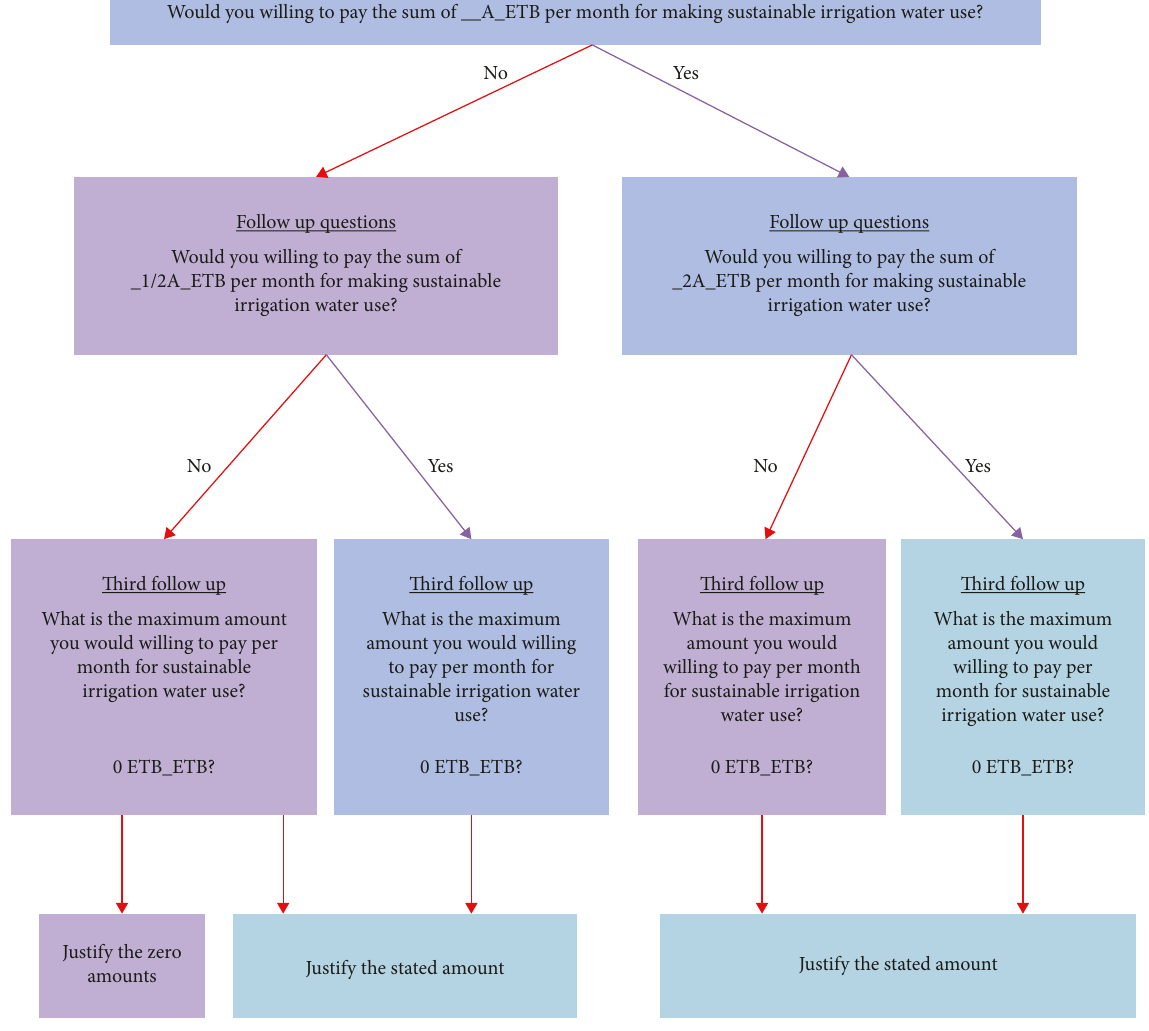
Figure 2: Set of responses for DBDC